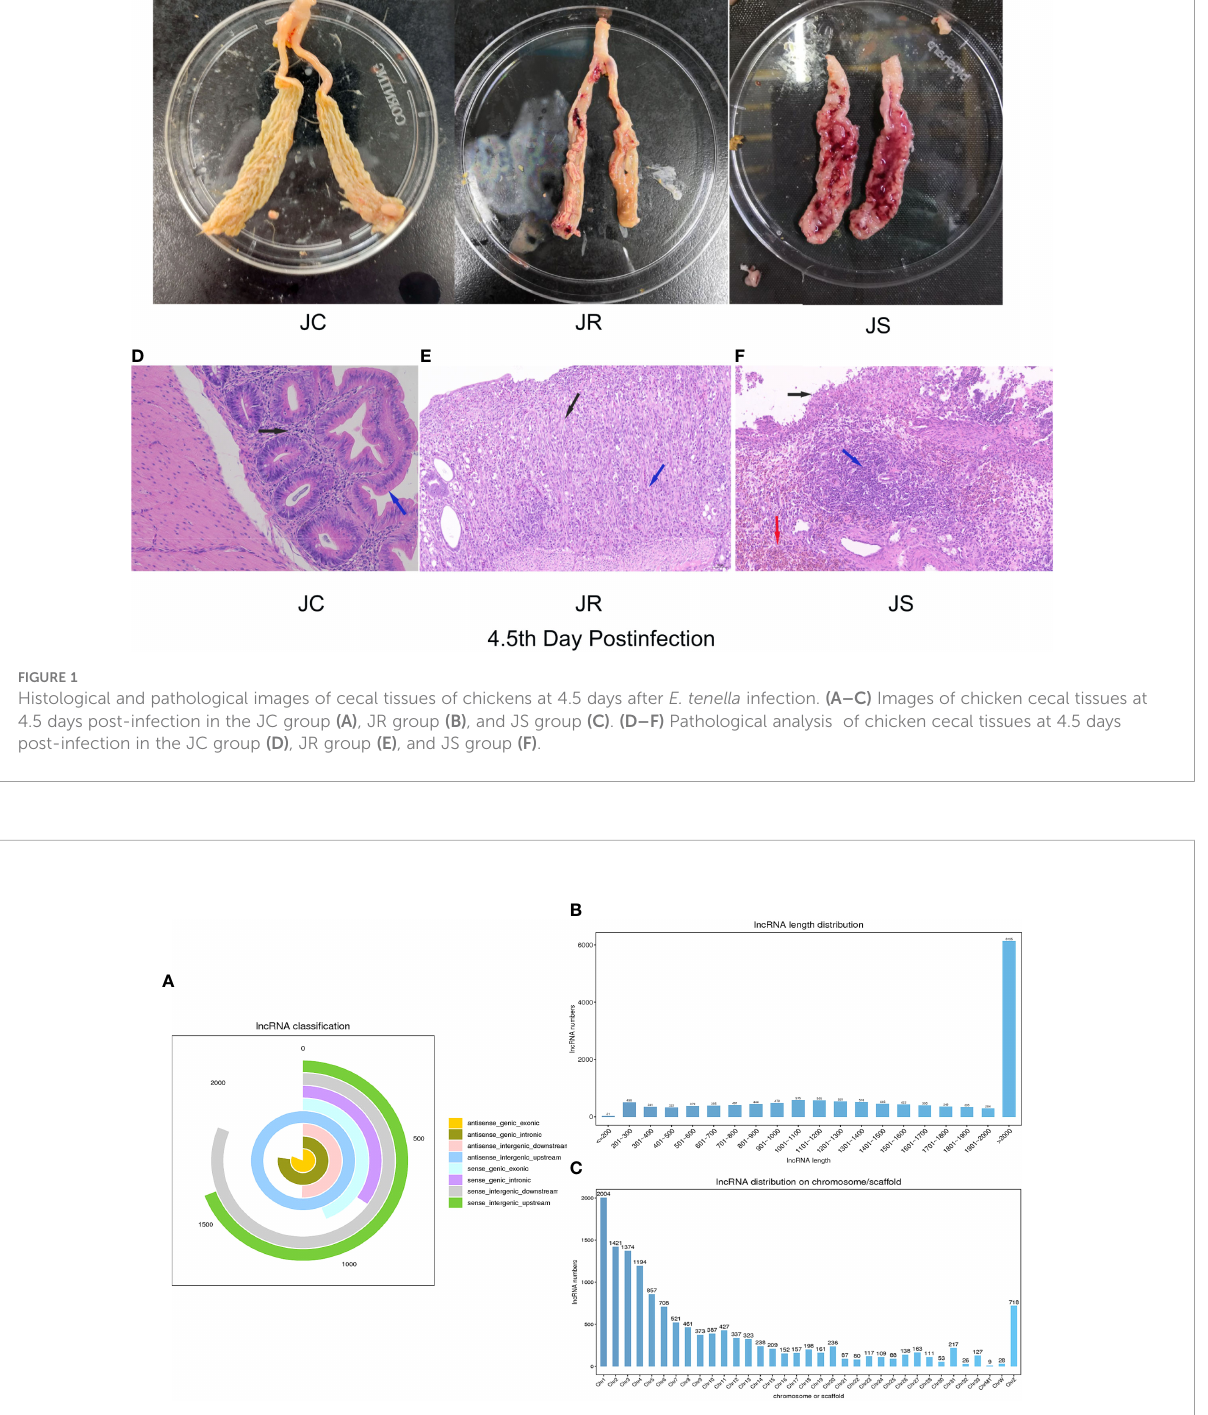
FIGURE 2 Characteristics of lncRNAs in chicken cecal tissues during E . tenella infection. (A) LncRNA classi fi cation. (B) The length distribution of the lncRNAs. (C) Chromosomal distribution of the